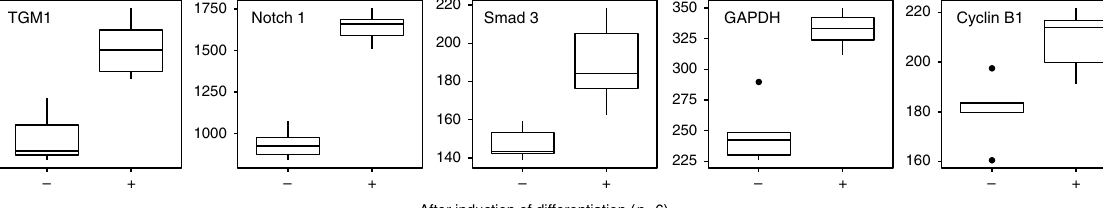
Fig. 2 ID-seq screen of PKIS identi fi es probes inducing skin stem cell differentiation. a Schematic overview of the protein kinase inhibitor set (PKIS) screen set-up. Kinase tree shows kinases targeted by the inhibitory probes (blue) and signi fi cantly enriched kinases (yellow, Fig. 4a). The probes target all major kinase families (TKL, STE, CK, AGC, CAMK, CMGC and TK). b To combine PKIS probe effects on multiple ID-seq molecular phenotypes to one measure, we performed principal component analysis on the PKIS data set using the signed log 10 p -values of the ID-seq analysis. Then, we clustered all molecular phenotypes and the top fi ve PCs to identify the PC summarising differentiation of the skin stem cells (in bold molecular phenotypes TGM1 and NOTCH1). c ID-seq measurement of differentiation marker TGM1, Notch 1, GAPDH, Cyclin B1 and SMAD3 upon inhibition of EGFR shows differentiation-induced phenotypic changes. (Boxplots with centre line indicating median, bounds of boxes showing upper and lower quartile, and whiskers illustrating 1.5 × interquartile range, n =